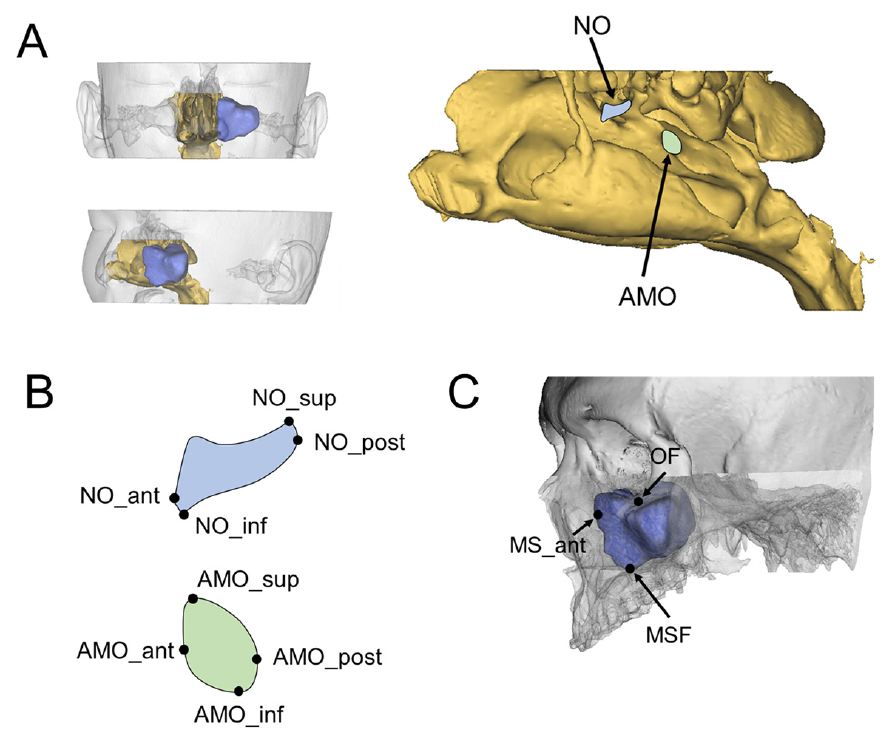
Figure 2. Determination of landmarks for the natural ostium and accessory maxillary ostium. ( A ) Three-dimensionally constructed nasal airway and left maxillary sinus. The natural ostium and accessory maxillary ostium can be found from the lateral view of the nasal airway. ( B , C ) Landmarks of the natural ostium, accessory maxillary ostium, and adjacent anatomic structures. After three- dimensional coordinates (x, y, z) for each landmark were obtained, the horizontal and vertical dimensions of the natural ostium and accessory maxillary ostium and the spatial position of the natural ostium and accessory maxillary ostium related to the adjacent anatomic landmarks, such as the maxillary sinus floor, anterior maxillary sinus wall, and orbital floor, were obtained. The definitions of each landmark are described in Table 1. NO, natural ostium; AMO, accessory maxillary ostium.